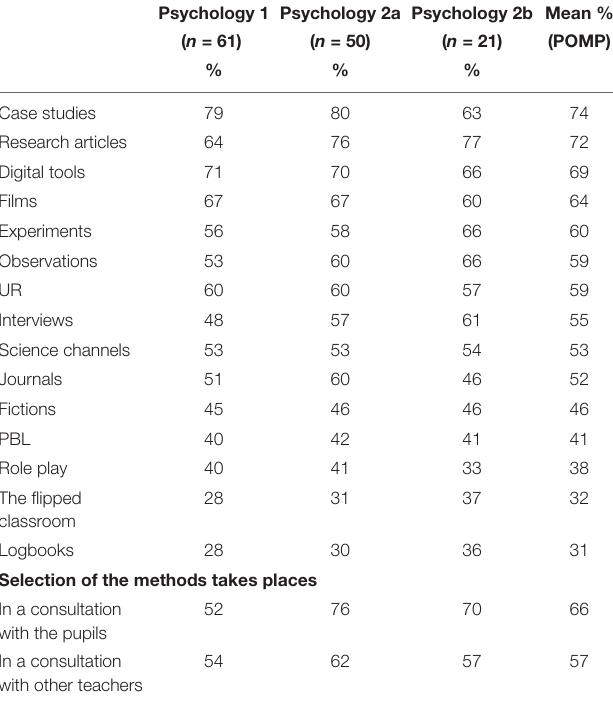
TABLE 6 | How often do you use the following methods for your